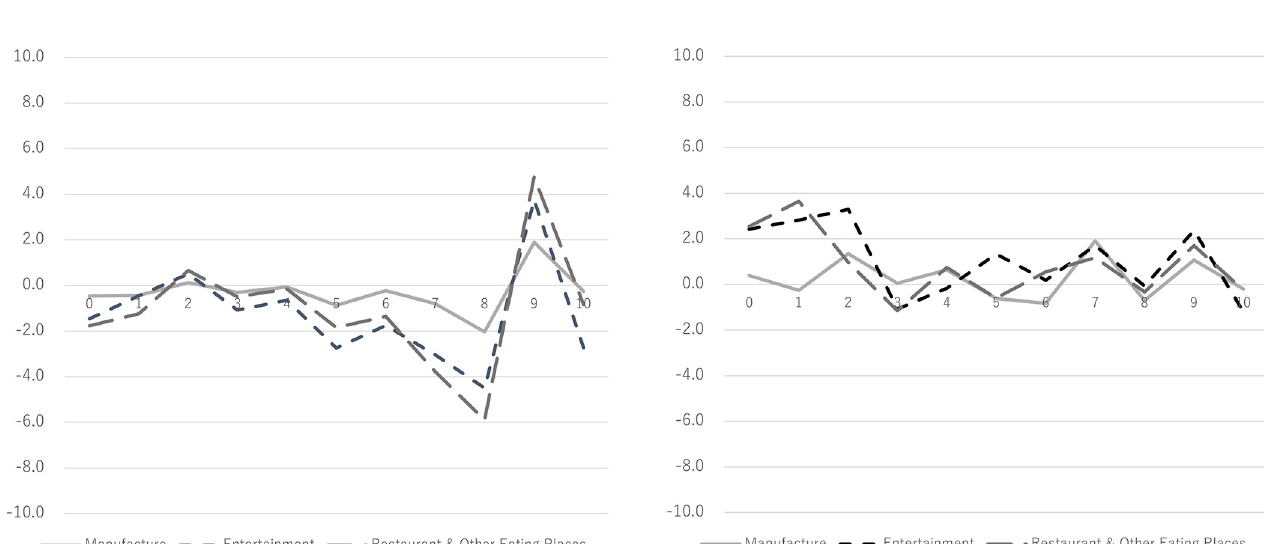
PLOS ONE | https://doi.org/10.1371/journal.pone.0278876 December14,